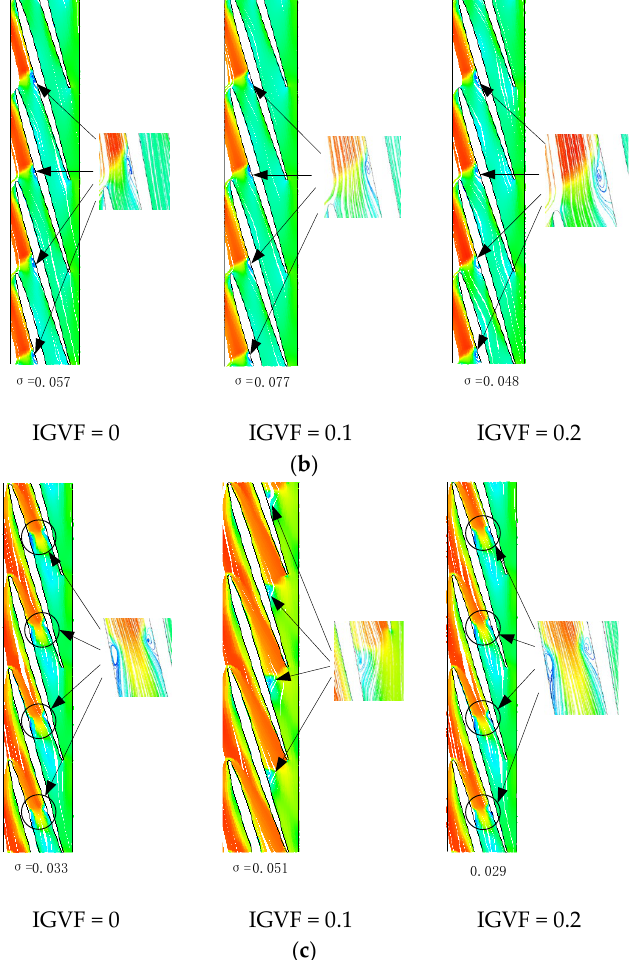
Figure 11. Velocity streamlines at 0.5 span under IGVF = 0, 0.1 and 0.2. ( a ) Critical cavitation; ( b ) severe cavitation; and ( c ) fracture cavitation.